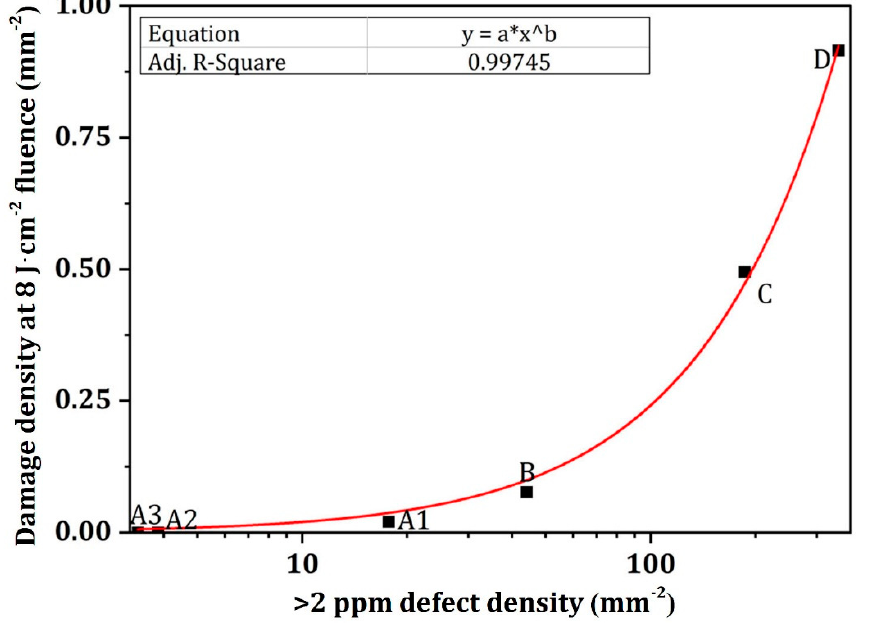
Figure 8. Fitting relationship between defect density with absorption greater than 2 ppm and damage density at 8 J·cm − 2 testing fluence.